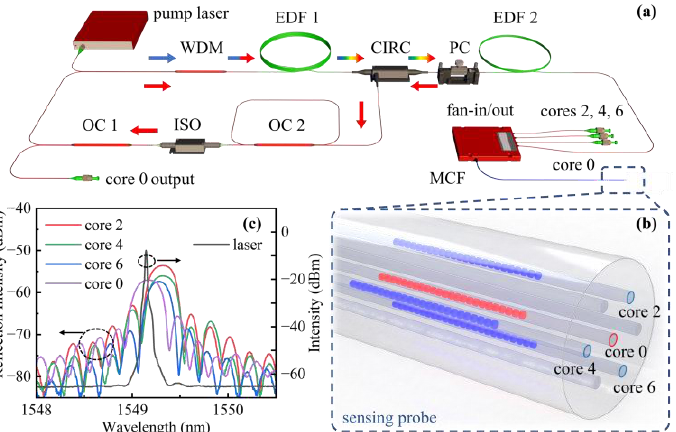
Figure 2. ( a ) Experimental setup for the ring cavity laser used for the interrogation of the two-dimensional accelerometer, ( b ) distribution of FBGs in SCF (i.e., sensing probe), ( c ) reflection spectra of the FBGs inscribed in the fiber cores and the output spectra of the laser.